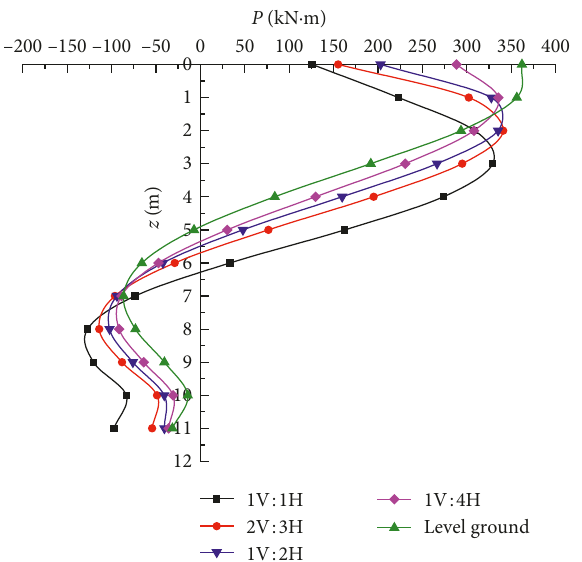
Figure 13: Lateral soil resistance versus depth relationships of different slope ratios for H 0 (cid:31)